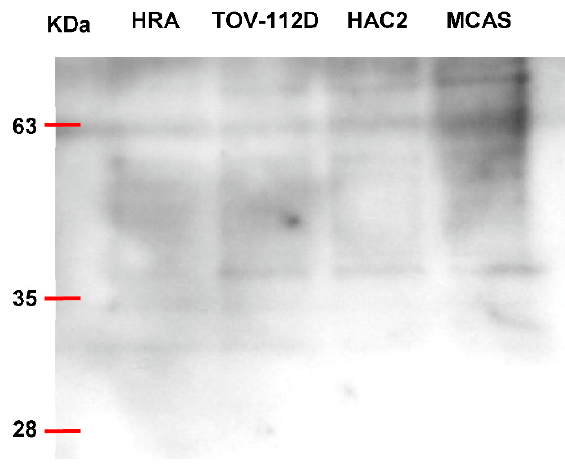
Figure 2. Exosome detection based on the expression of exosomal marker CD63. Exosomes isolated from culture media of the indicated ovarian cancer cell lines were subjected to western blotting analysis using anti-CD63 antibody.